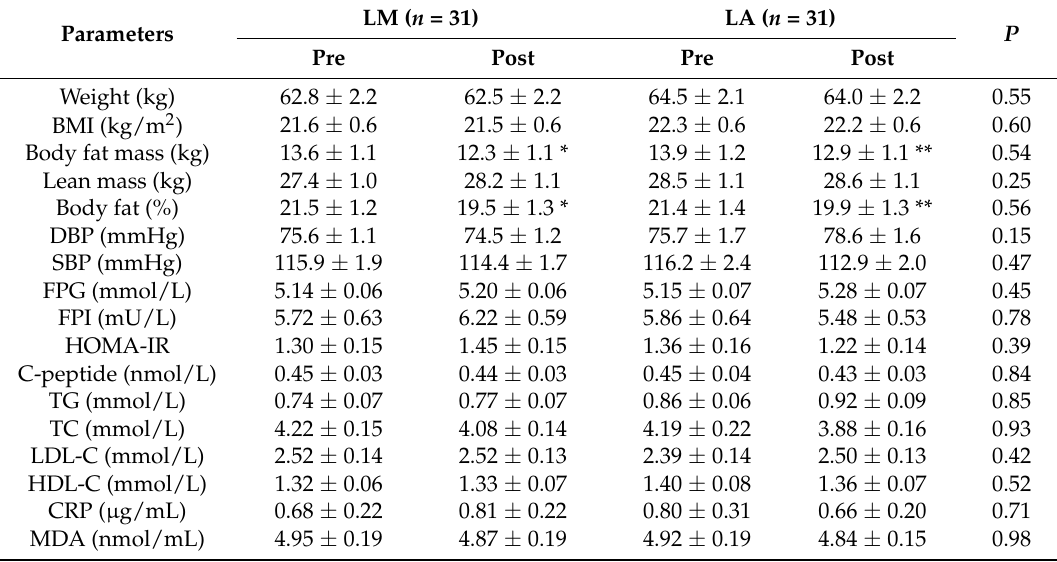
Body composition and cardiometabolic biomarkers before and after whole milk supplementation in subjects with or without lactose malabsorption 1